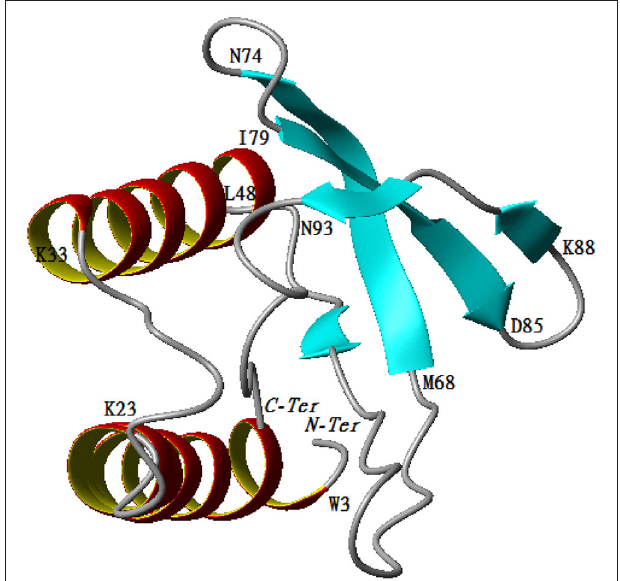
FIGURE 5 | Cartoon representation of 3D structure of protease 1 with the active site localization. FIGURE 6 | Cartoon representation of 3D structure of protease